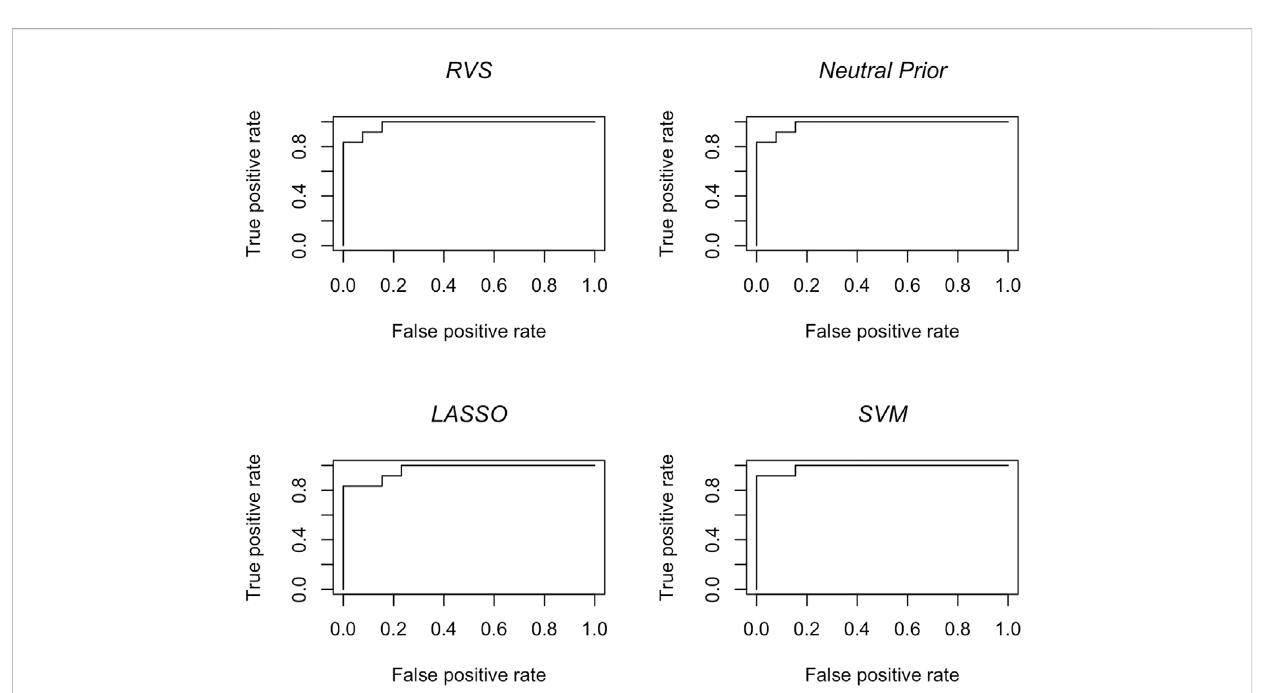
FIGURE 5 Classi fi cation accuracy: ROC curves for the RVS model, the Bayesian model with a neutral prior, lasso logistic regression, and SVM on a test set with unequal group sizes, as described in Section